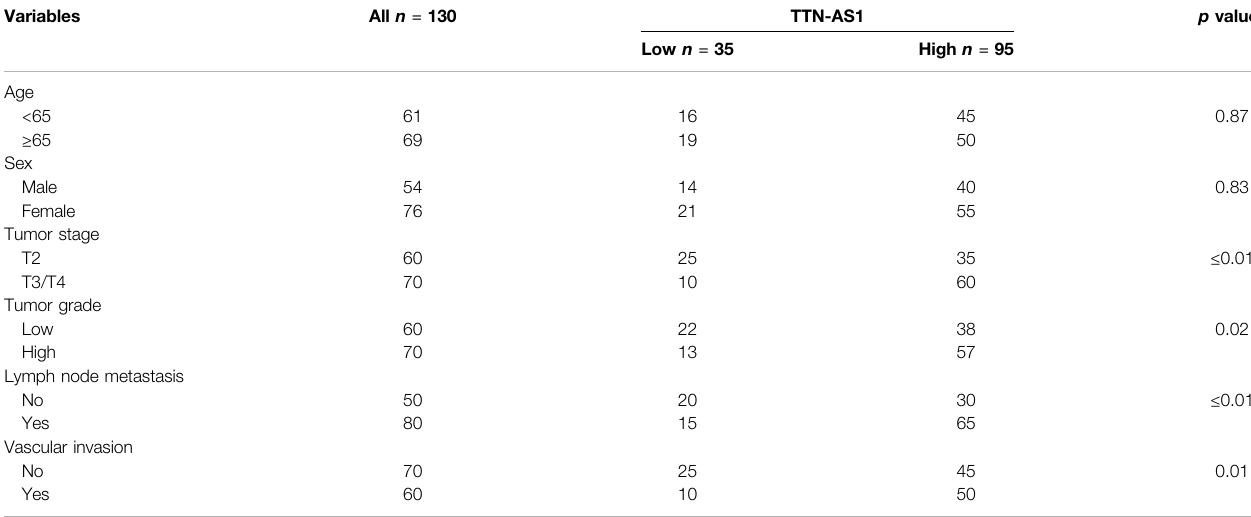
TABLE 1 | Clinicopathologic variables and TTN-AS1 expression in 130 bladder cancer patients. Variables